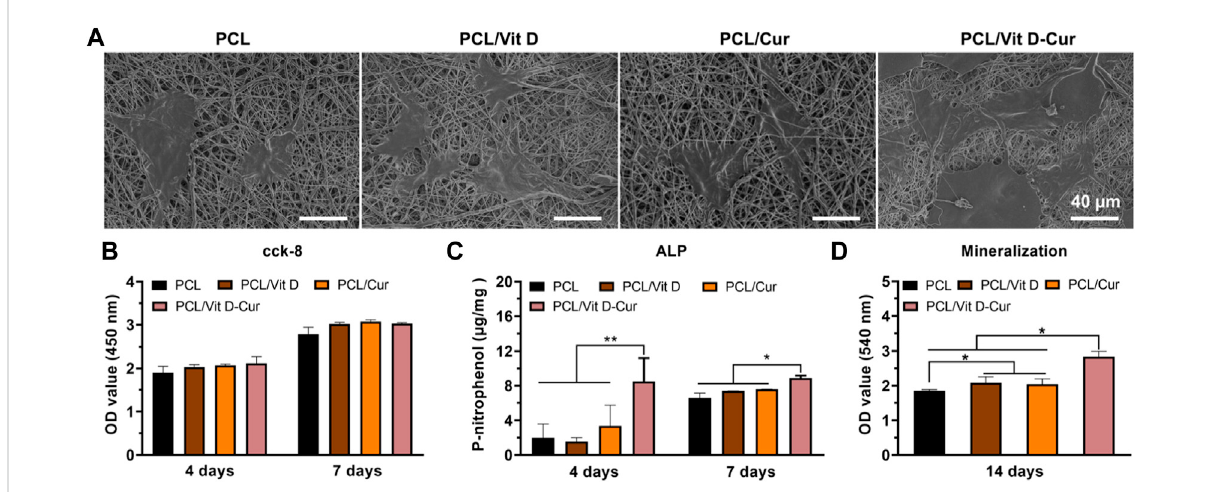
FIGURE 7 The expression of anti-in fl ammatory (IL-10, IL-1ra), pro-in fl ammatory (TNF- α , IL-1 β ), and osteogenic (BMP-2, VEGF) genes by RAW264.7 cells grown on different scaffolds. The values were normalized by GAPDH (* p < 0.05, ** p < 0.01).